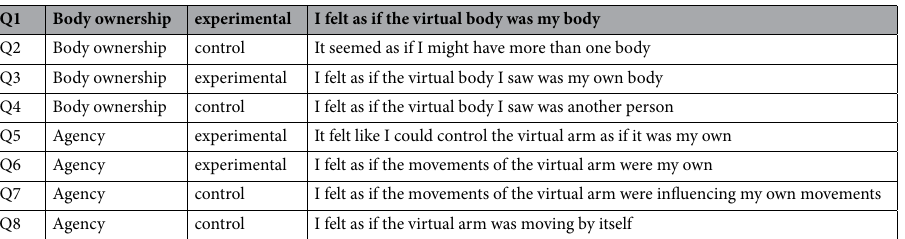
Table 1. Embodiment illusion questionnaire. Embodiment_Index = [(Q1−Q2 + Q3−Q4)/4] + [(Q5 + Q6−Q7− Q8)/4].